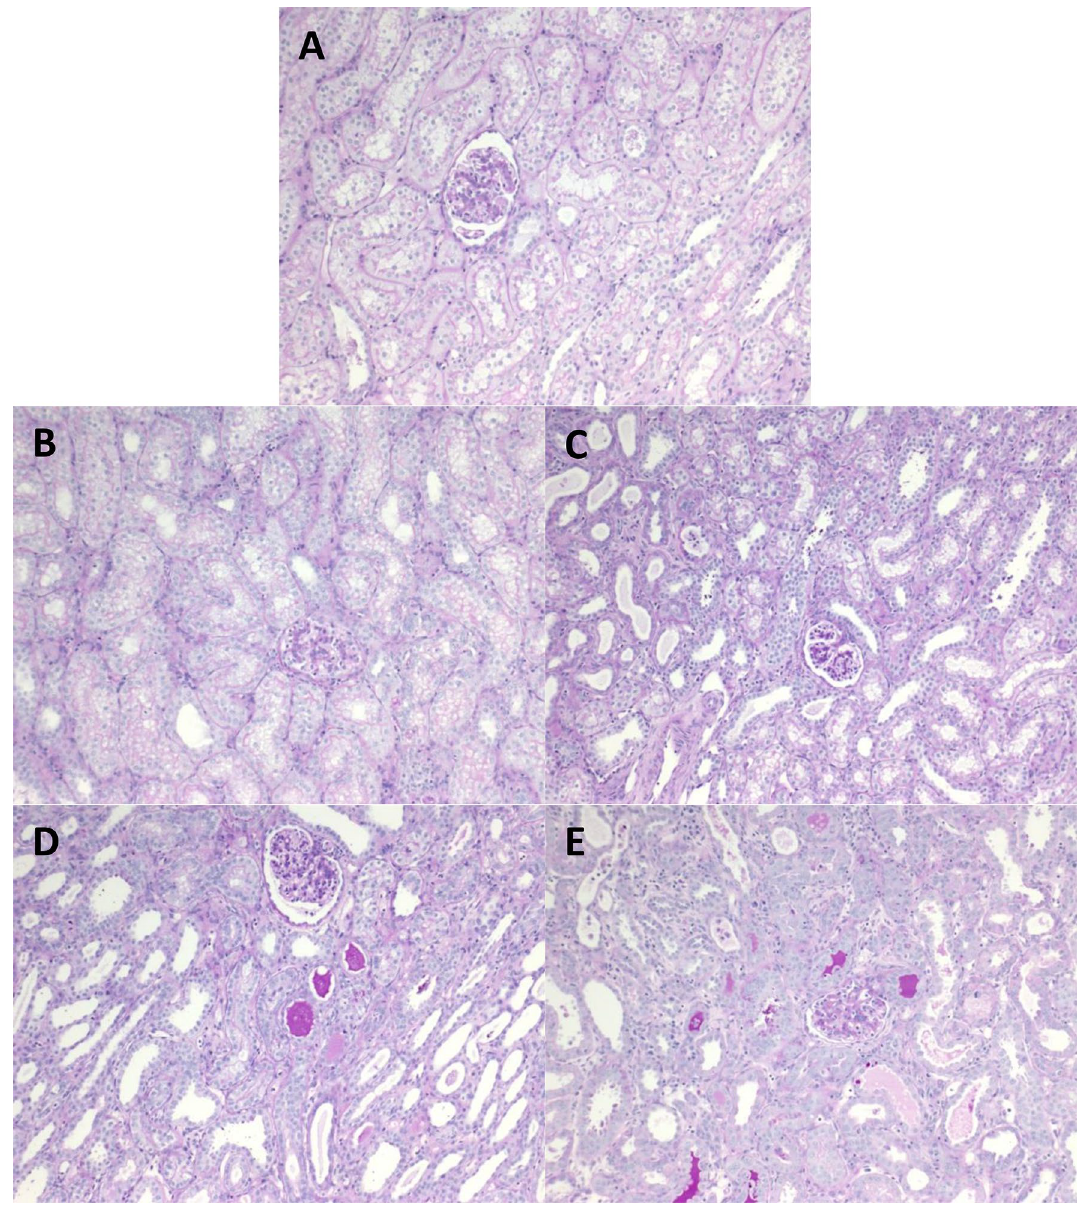
Figure 5. Representative periodic-acid-Schiff (PAS) staining. Post-operative day 7 specimens were collected of kidneys subjected to ( A ) no warm ischemia (heart-beating donor [HBD] group), or ( B ) 30 min